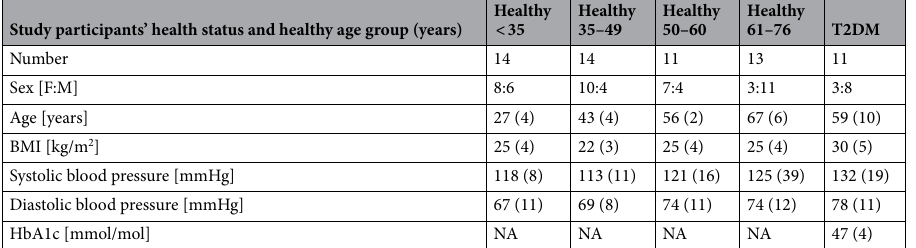
Table 2. Clinical characteristics of study participants per health status and age group. Values are expressed in mean (standard deviation). T2DM type 2 diabetes mellitus, F female, M male, BMI body mass index, HbA1c glycated haemoglobin, NA not